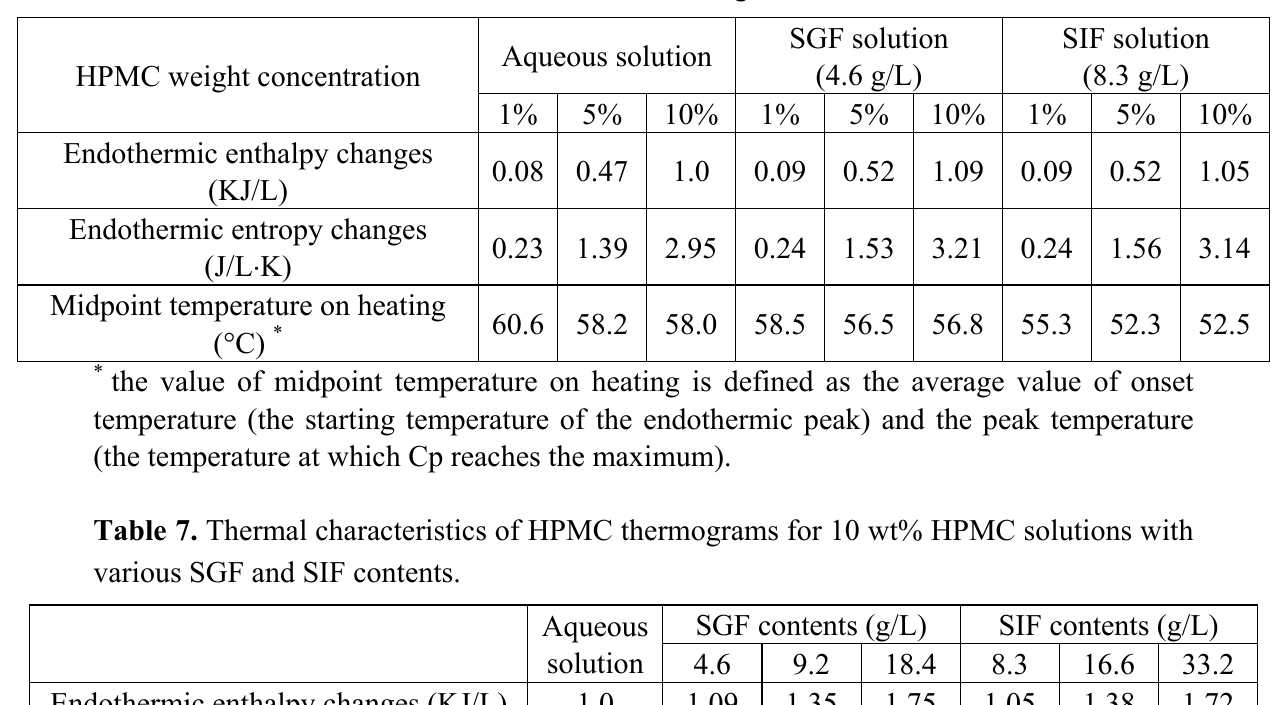
Table 6. Thermal characteristics of HPMC thermograms for various HPMC solutions.